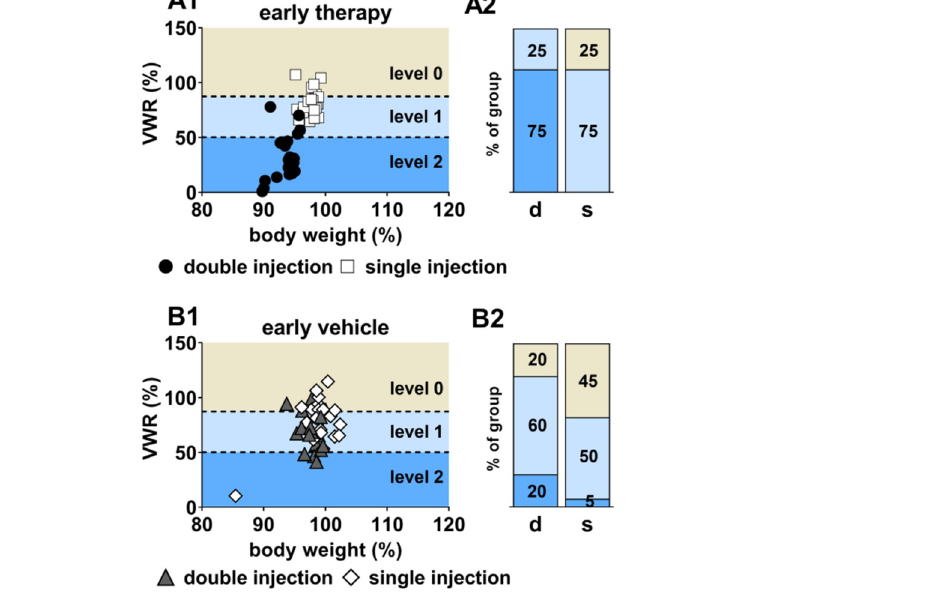
Fig 9. Severity level cluster for the early treatment period. Allocation to levels within cluster model for the therapy group (A) and vehicle group (B).